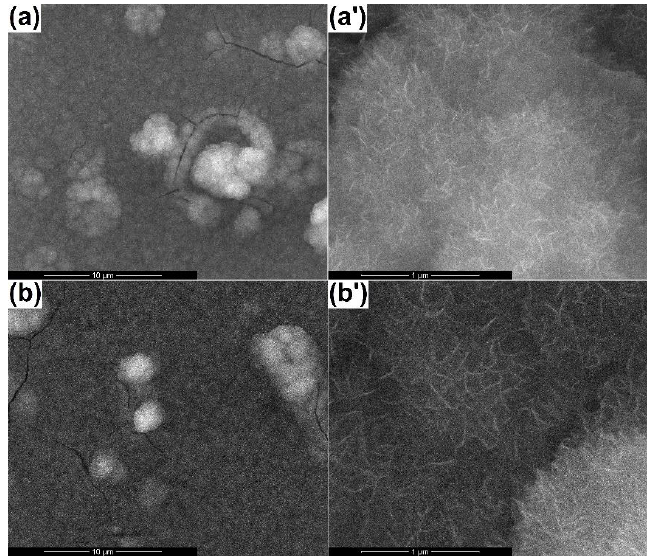
Figure 6. SEM images of the coatings processed at ( a -10,000× and a’ -100,000×) room temperature and ( b -10,000× and b’ -100,000×) 300 °C, after immersion in simulated body fluid (SBF) for 28 days.